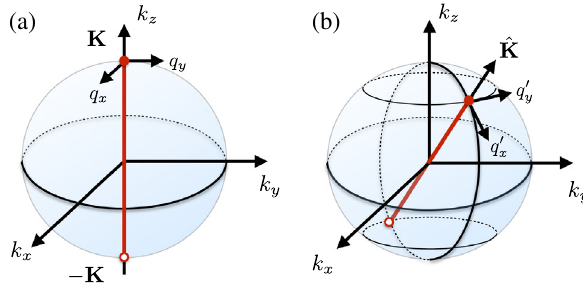
FIG. 1. Fermi surface and rotation axis. (a) Schematic repre- sentation of the Fermi surface (blue sphere) and the rotation axis along the z direction (red solid line). In most cases, in particular in the case of the pairing states j J; M i , one may take the rotation axis along ˆ z . The Fermi surface momenta on the rotation axis are (cid:2) K ¼ (cid:2) k Fv ˆ z (or (cid:2) k Fc ˆ z in the case of the conduction band). (b) In general, the axis of special rotational symmetry may be arbitrary. In the case of pairing states with discrete symmetry, there may be more than one discrete rotation axis, which is familiar from crystal point